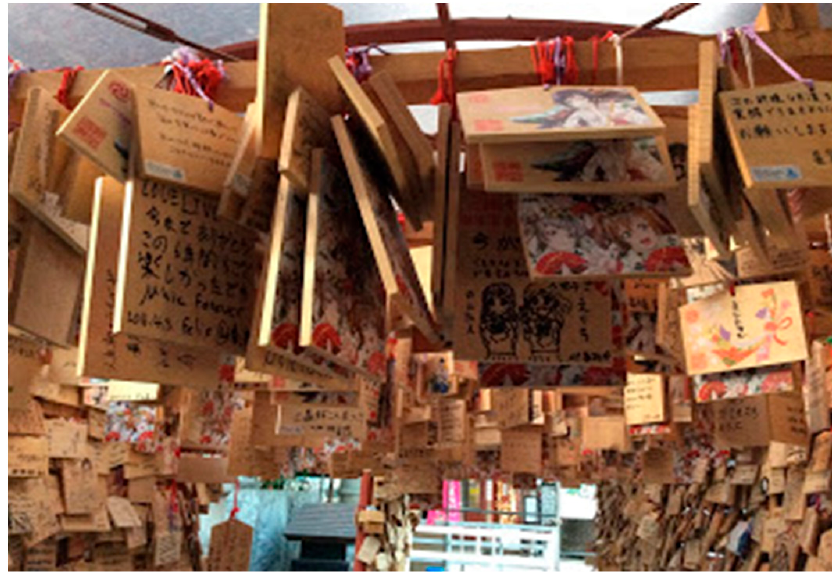
Figure 1. Ema dedicated to the shrine where the TV anime Love Live! was set.